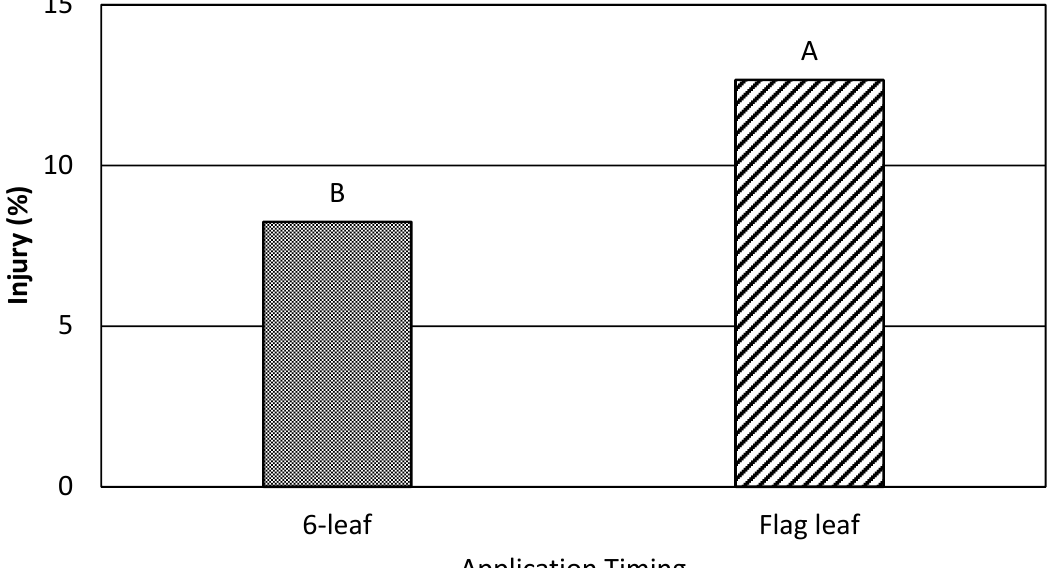
Figure 4. Grain sorghum injury from herbicide drifts at 28 DAA as affected by the application timing in 2017. Data were averaged over herbicides used in this study. Same letters on bars indicate no significant differences at p < 0.05, according to Fisher’s least significant difference test.